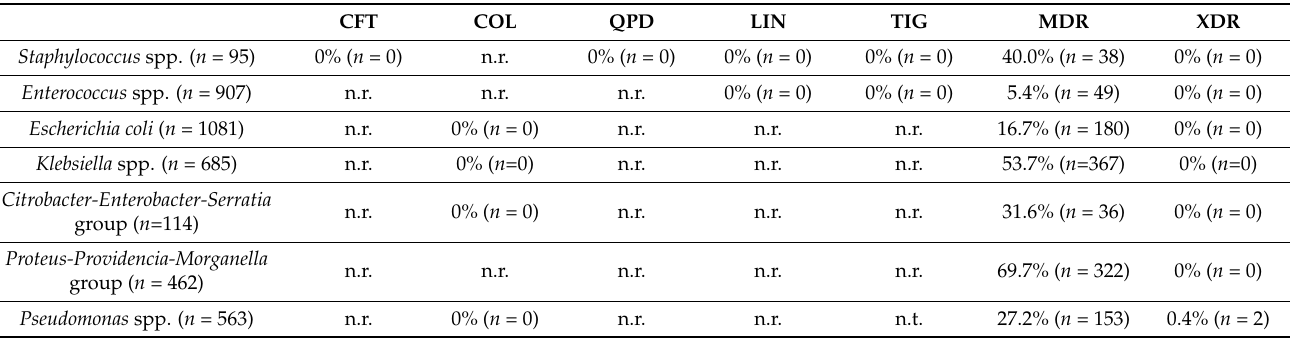
Table 9. Percentage of resistant isolates from inpatient UTIs against WHO Reserve antibiotics and rates of MDR and XDR isolates.